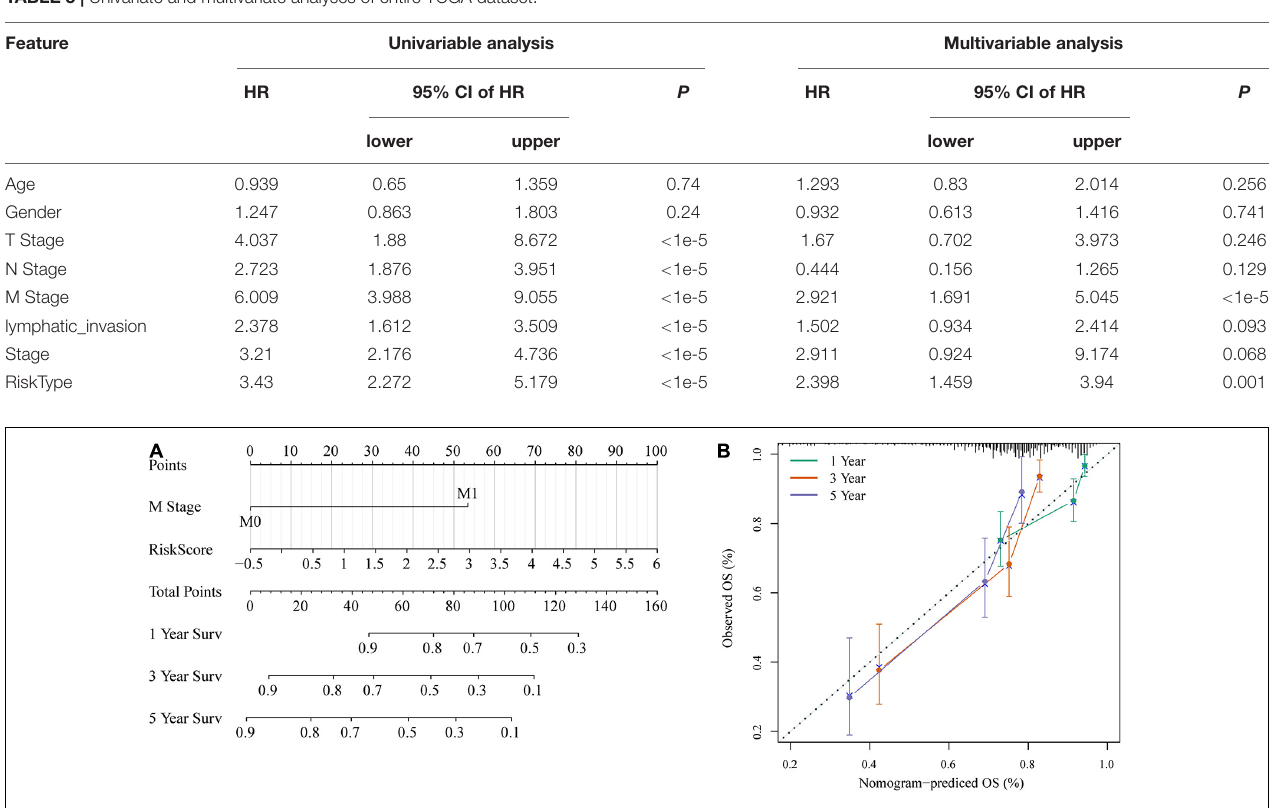
FIGURE 12 | Nomogram and its clinical utility. (A) Nomogram. (B) Nomogram correction chart.